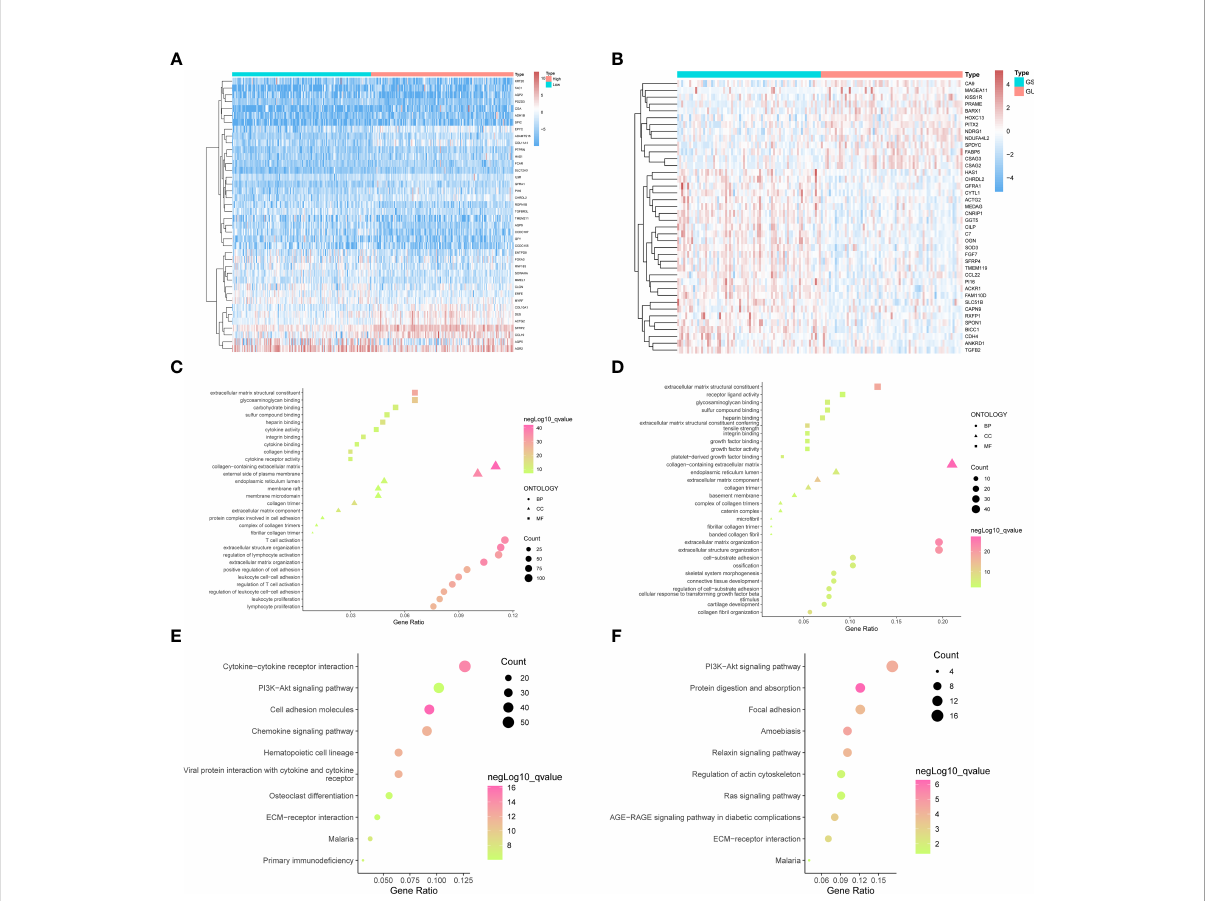
FIGURE 1 The top forty genes in the StromalScore related genes (A) and GIRGs (B) groups were respectively selected according to the descending order of the signi fi cance of the expression difference. The heatmap was drawn, from the color red to blue, representing the expression from high to low. The result from GO analyses of stromal-related DEGs (C) and GIRGs (D) was separately displayed. The pathways with the top 10 high gene ratios, respectively, belonging to different oncologies, were shaped into different graphs. In the stromal-related DEGs set, the pathways were mainly enriched in pathways concerning immune cell activity. For GIRGs, there is massive enrichment in pathways related to an extracellular matrix structure. Pathways with the top 10 high gene ratios according to KEGG analyses were exhibited. For stromal-related DEGs (E) and GIRGs (F)